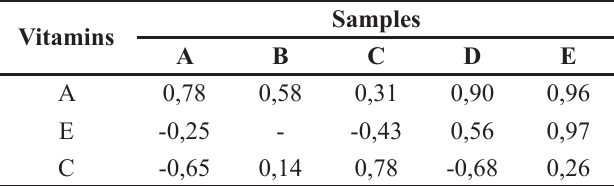
TABLE VI - Correlation* between the time in months remaining until expiration date and the values of vitamins determined at the time of analysis